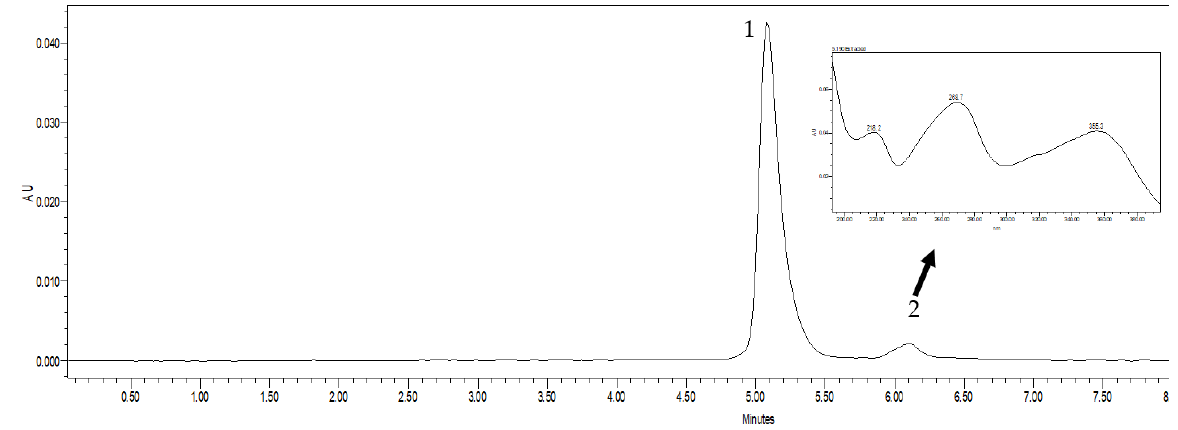
Figure 6. Chromatogram of oxytetracycline in the polyphosphate ester-type P6 transporter. Along with the main peak of oxytetracycline, there are three peaks with reduced mobility in the chromatograms. Under these conditions, an antibiotic base and accompanying unidentified components are detected. The proportion of unidentified components ranges from 1.4 to 4.7%. Oxytetracycline content was 11.9 mg/mL in the